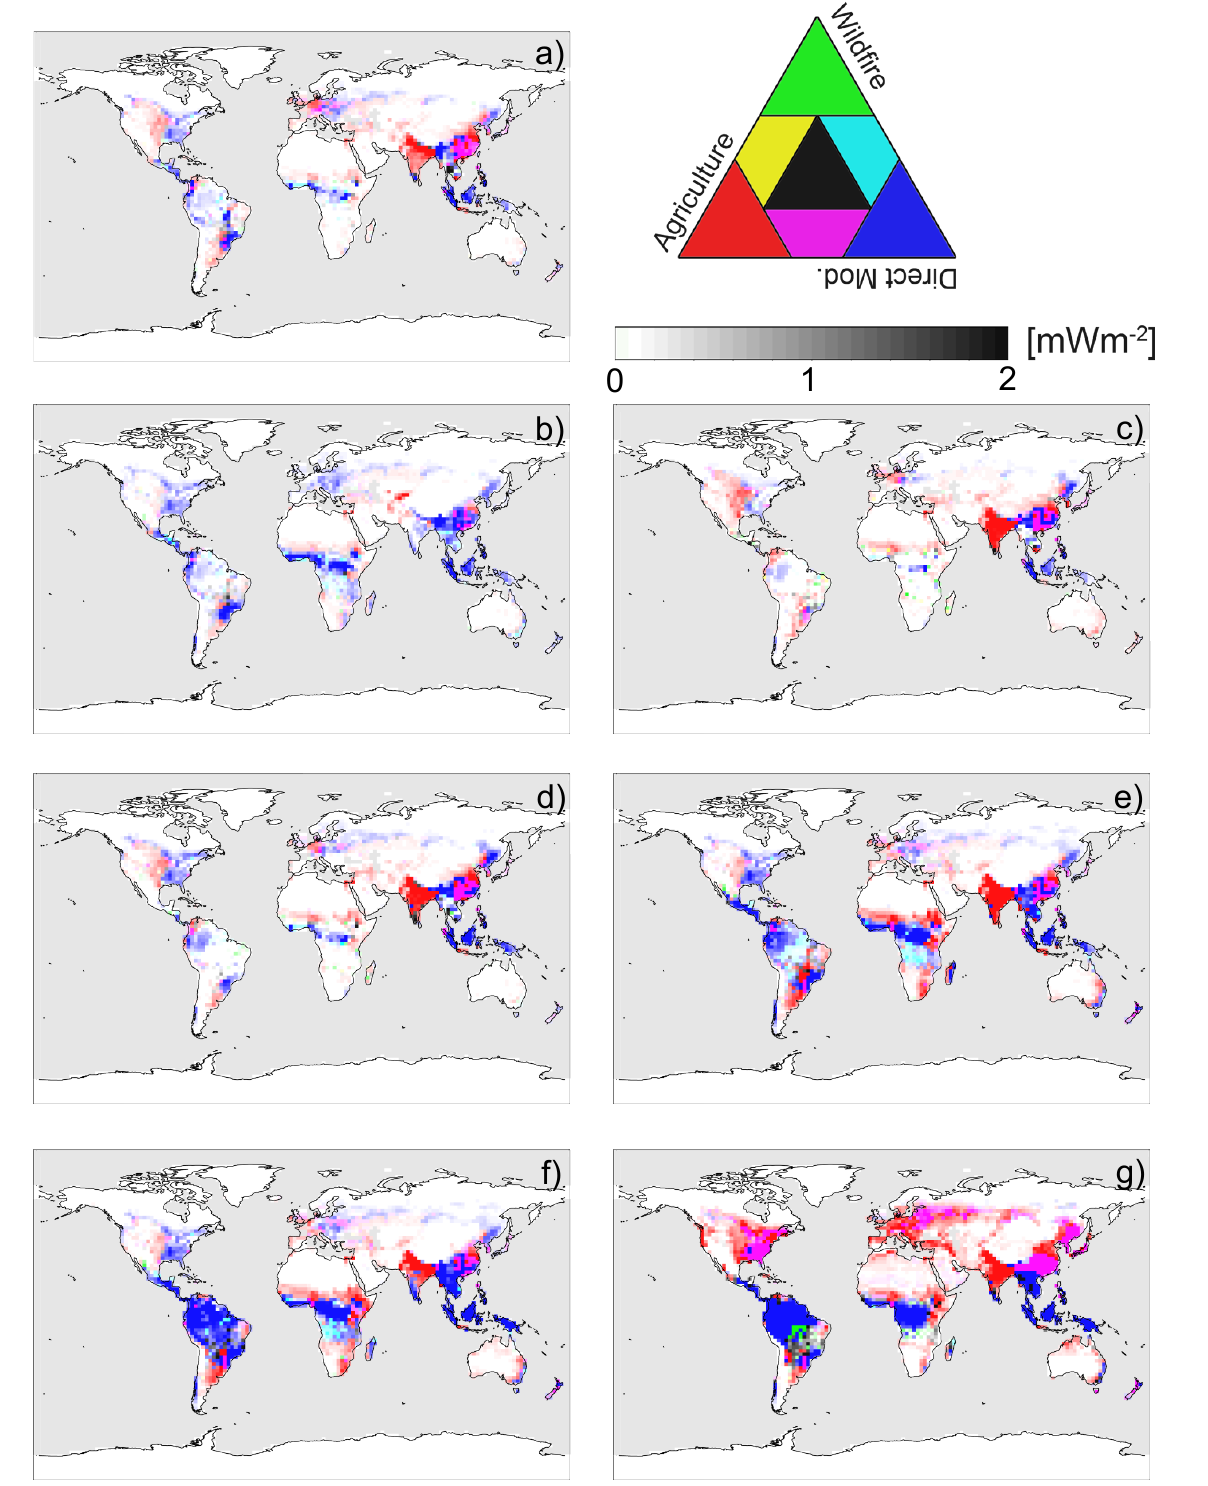
Figure 6. Spatial distribution of the sources of LULCC RF by sector for (a) 2010, and the year 2100 given the projections of (b) RCP2.6, from direct modifications (blue), agriculture (red), and changes to wildfires (green). Where more than one sector contributes to the total RF, the colors are blended according to the color triangle in the top right of the figure. The darkness of the coloring indicates the total magnitude of the RF at each point following the scale in the top right of the